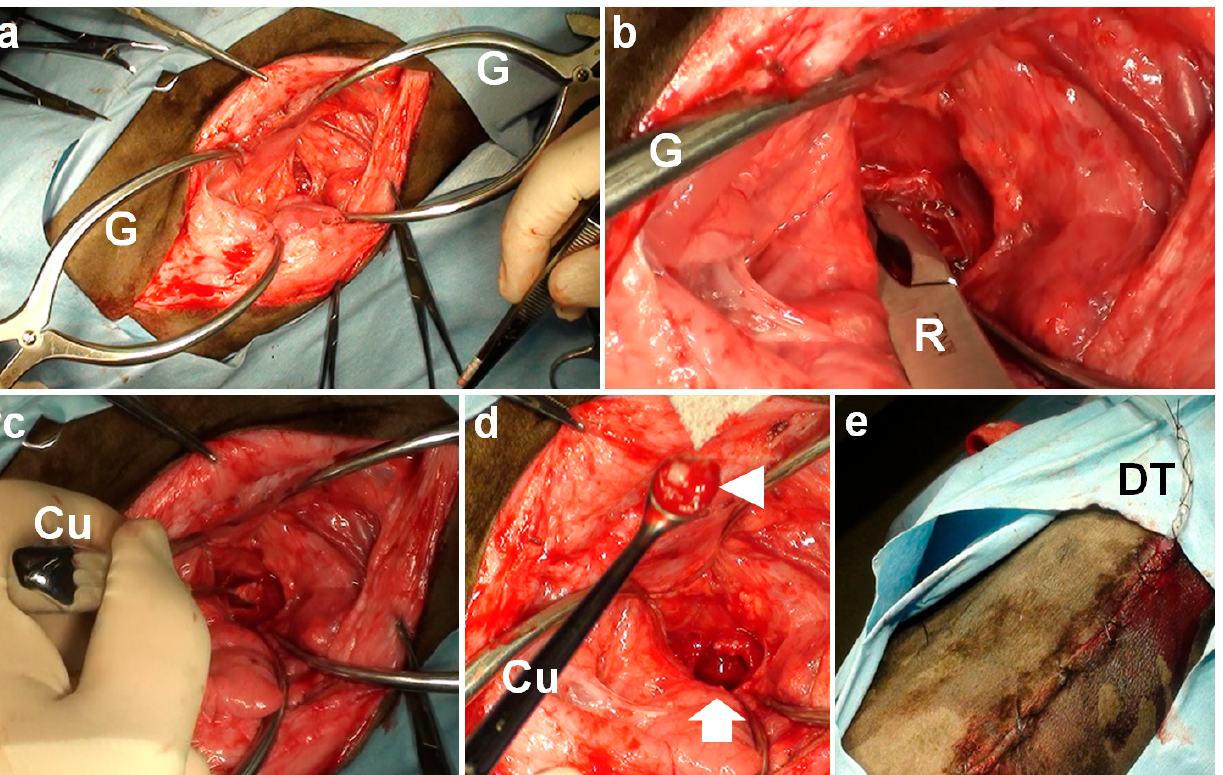
Figure 4. Intraoperative photos of ventral bulla osteotomy in Case 2. ( a ) Two Gelpi retractors (G) are used to extend the surgical opening. ( b ) A bone rongeur (R) is used to make a perforation in the tympanic bulla. ( c ) A curette (Cu) is inserted into the tympanic cavity. ( d ) The mucoid pus material (arrowhead) is subsequently removed from the perforated ventral surface of the tympanic bulla (arrow) using a curette (Cu). ( e ) A drainage tube (DT) is secured to the skin with Chinese finger trap suturing.